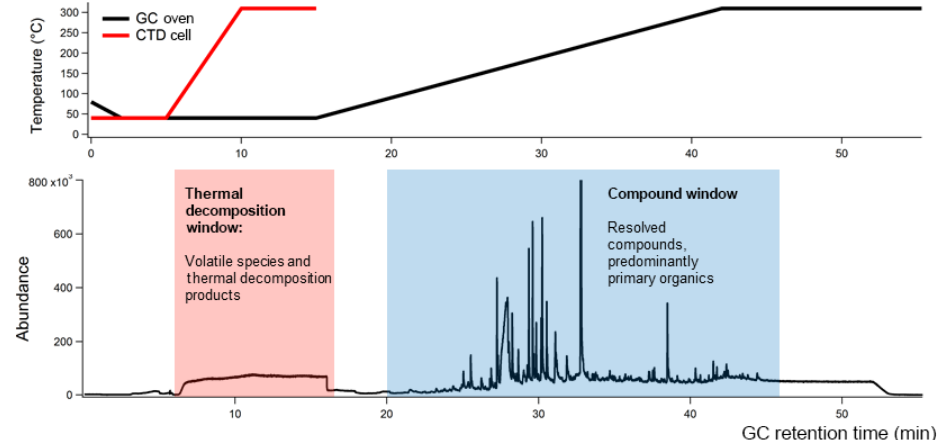
Figure 1. An example TAG chromatogram with GC oven and TAG collection and thermal desorption (CTD) cell temperature ramp programs.